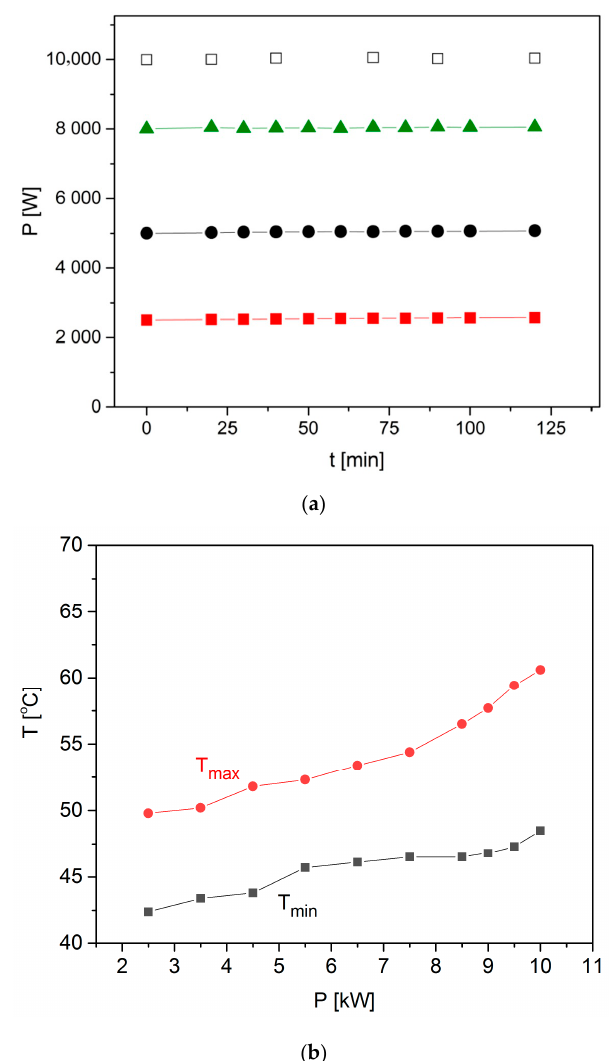
Figure 10. ( a ) Stability of the power output P of a V-type PEMFC stack with constant electrical load vs. duration of experiments . ( b ) Variation in minimal (T min ) or maximal (T max ) temperature recorded during PEMFC stack performance under electrical load, from 2.5 to 10 kW. Data refer to the conditions described in Figure 10a.